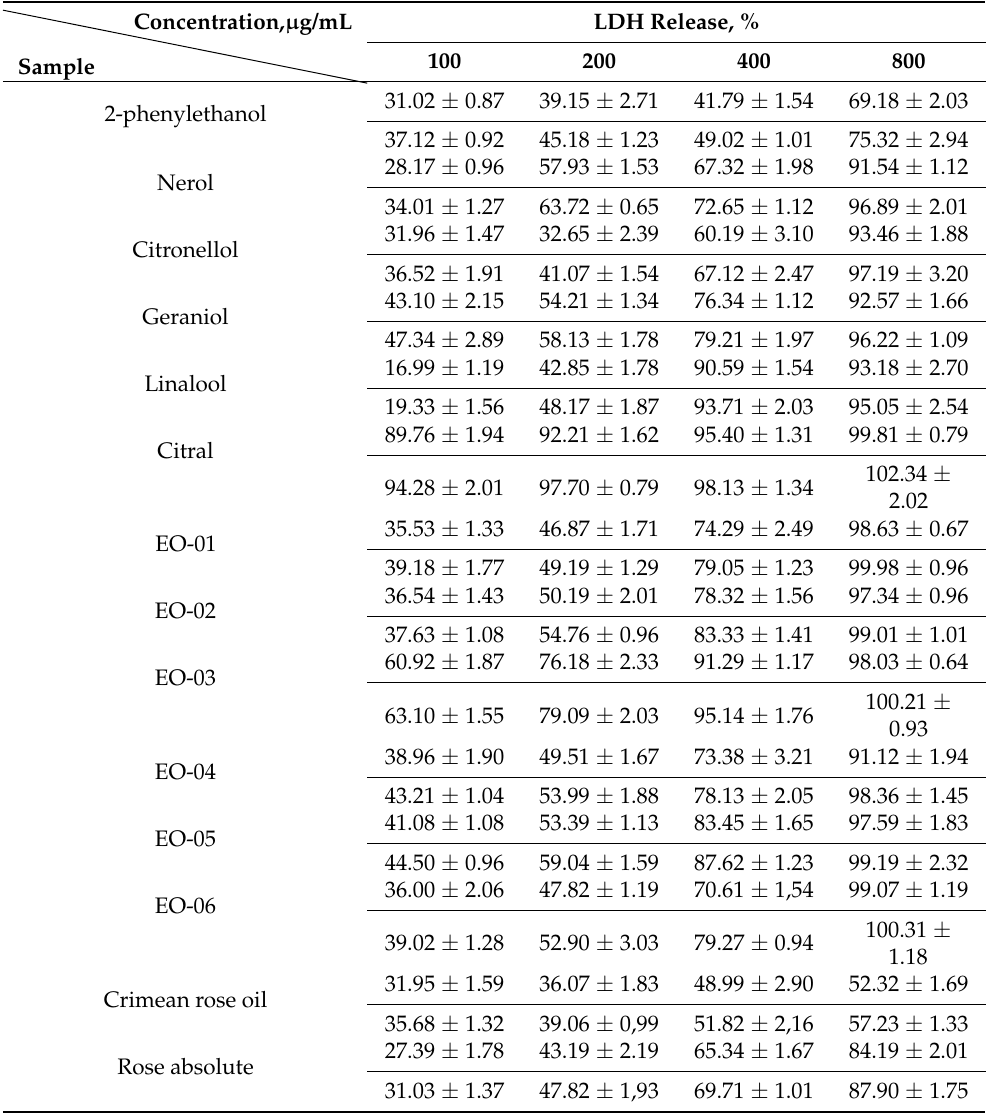
Table 3. LDH release in cells treated with Eremothecium and rose oils, and their compo- nents